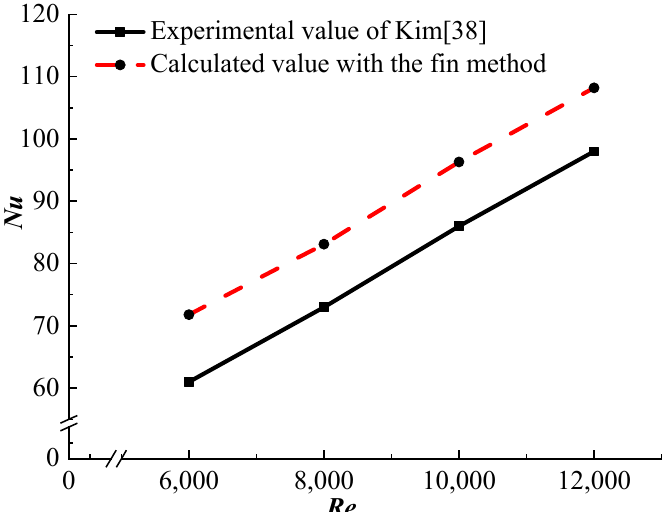
Figure 3. Comparison of the experimental value of Kim [38] and calculated value with the fin method.